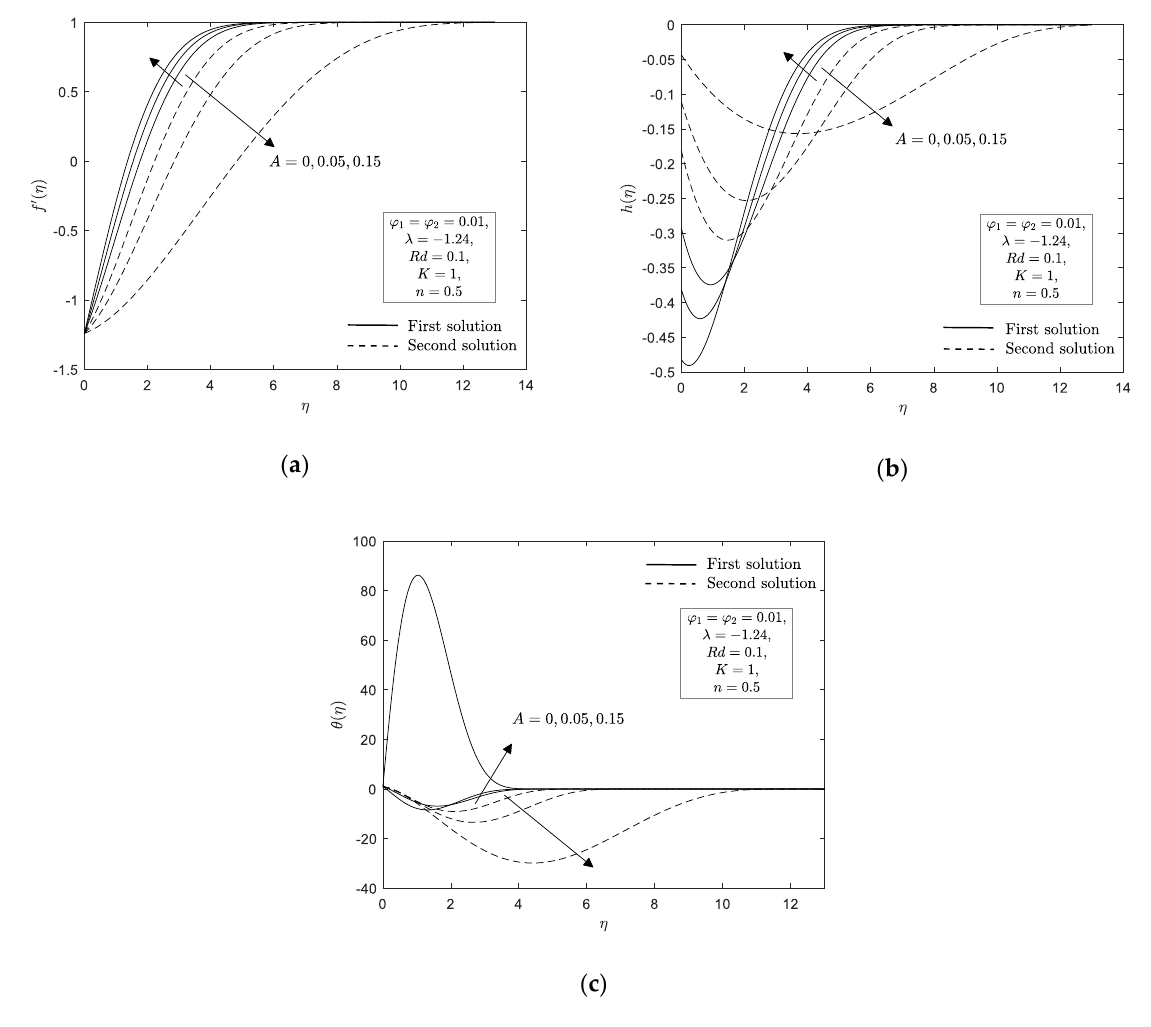
Figure 5. ( a ) f (cid:48) ( η ) ; ( b ) h ( η ) ; ( c ) θ ( η ) for various A .